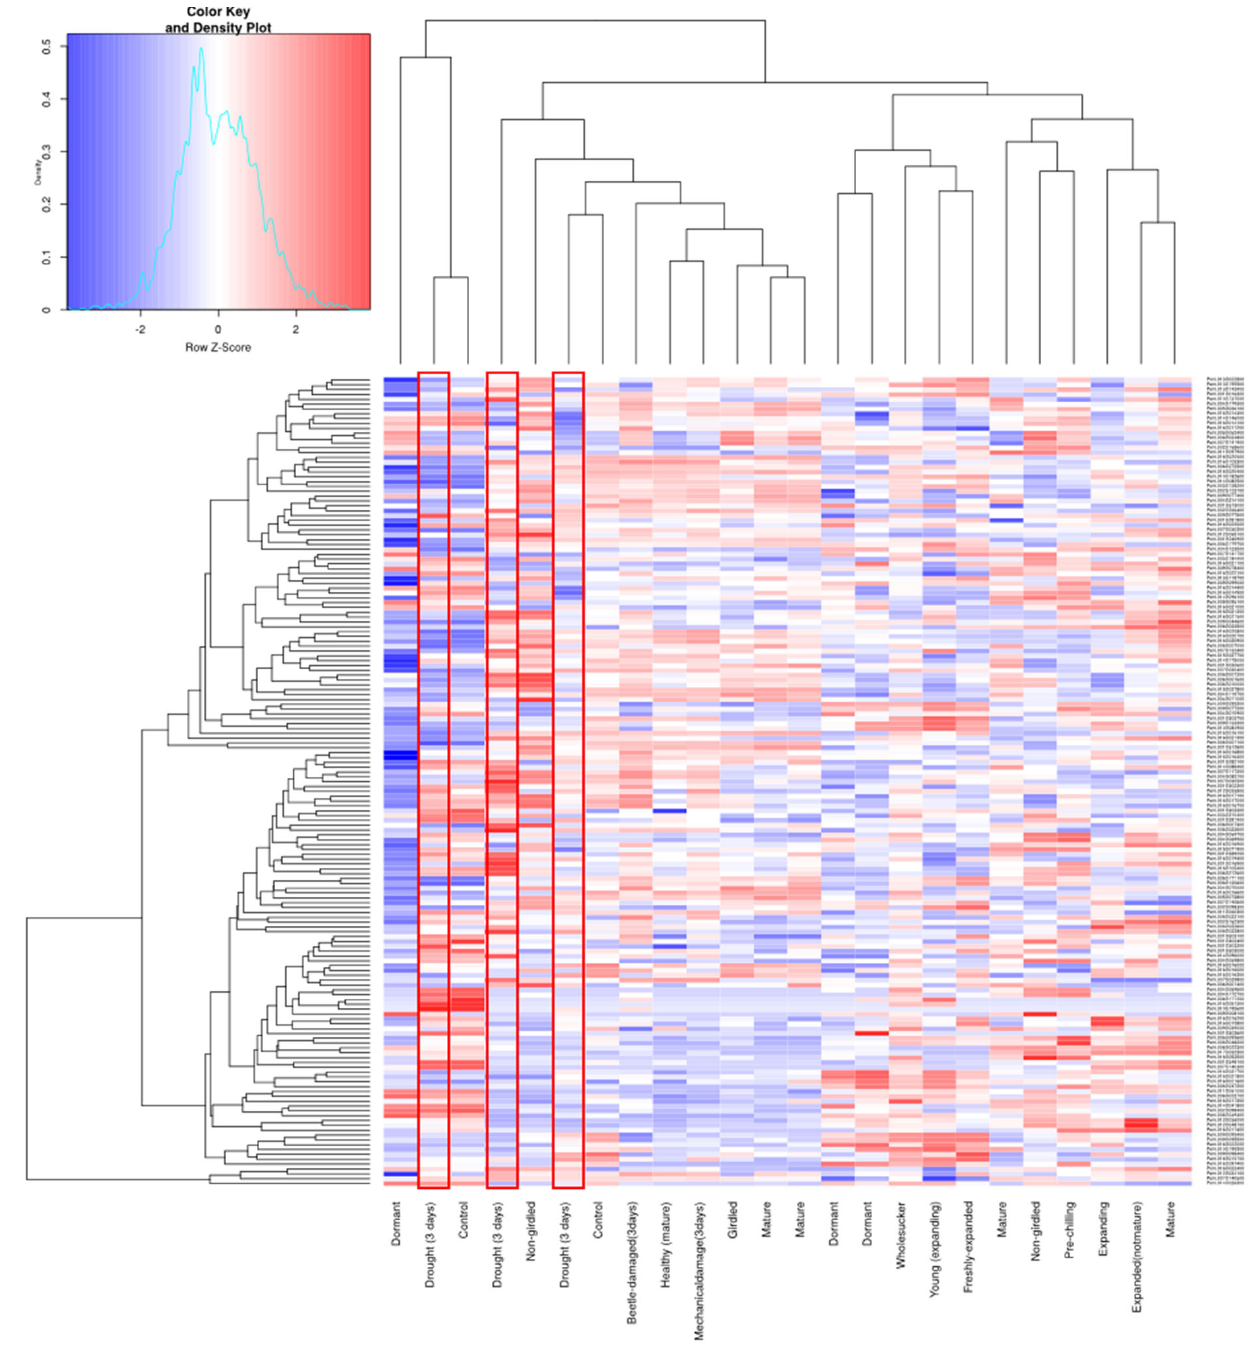
Figure 6. Heat map of 168 expressed UDP glycosyltransferases (UGTs) across different treatments in the Populus genome . The highlighted areas show the up- and down-regulated UGT genes against drought treatment.